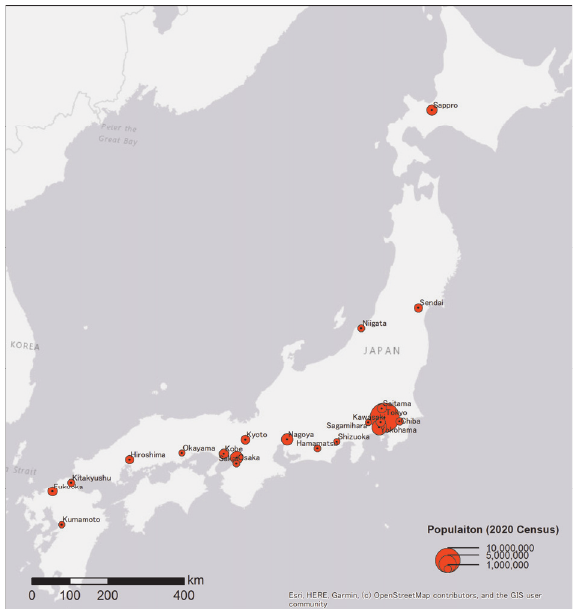
Figure 1 . The study area with the location of analyzed cities